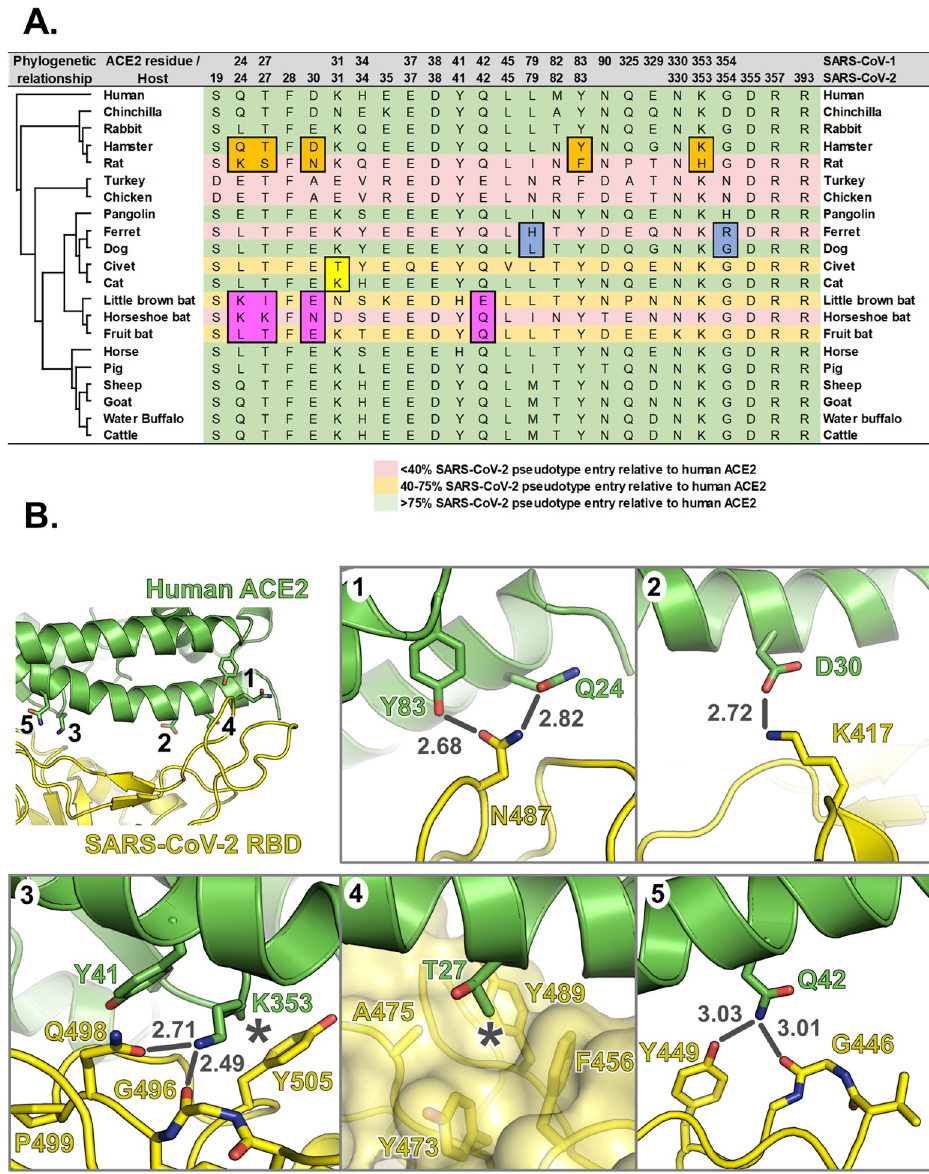
Fig 5. Substitutions at the interface between SARS-CoV-2 RBD and mammalian ACE2 proteins impact receptor utilisation. (A) Residues of mammalian ACE2 sequences used in this study that are predicted to interact with the RBD SARS-CoV and SARS-CoV-2, based on the structures of human ACE2 in complex with SARS-CoV [19] and SARS-CoV-2 [6]. Differences between closely related species that may impact RBD binding are highlighted. (B) Interface between human ACE2 (green) and SARS-CoV-2 RBD (yellow). Insets 1 to 5 show molecular interactions discussed in the main text. Bonds that may be disrupted are shown as grey lines, with bond distances in grey text, and hydrophobic interactions that may be disrupted are marked with asterisks. ACE2, angiotensin-converting enzyme 2; RBD, receptor binding domain; SARS-CoV, SARS Coronavirus; SARS-CoV-2, SARS Coronavirus 2.